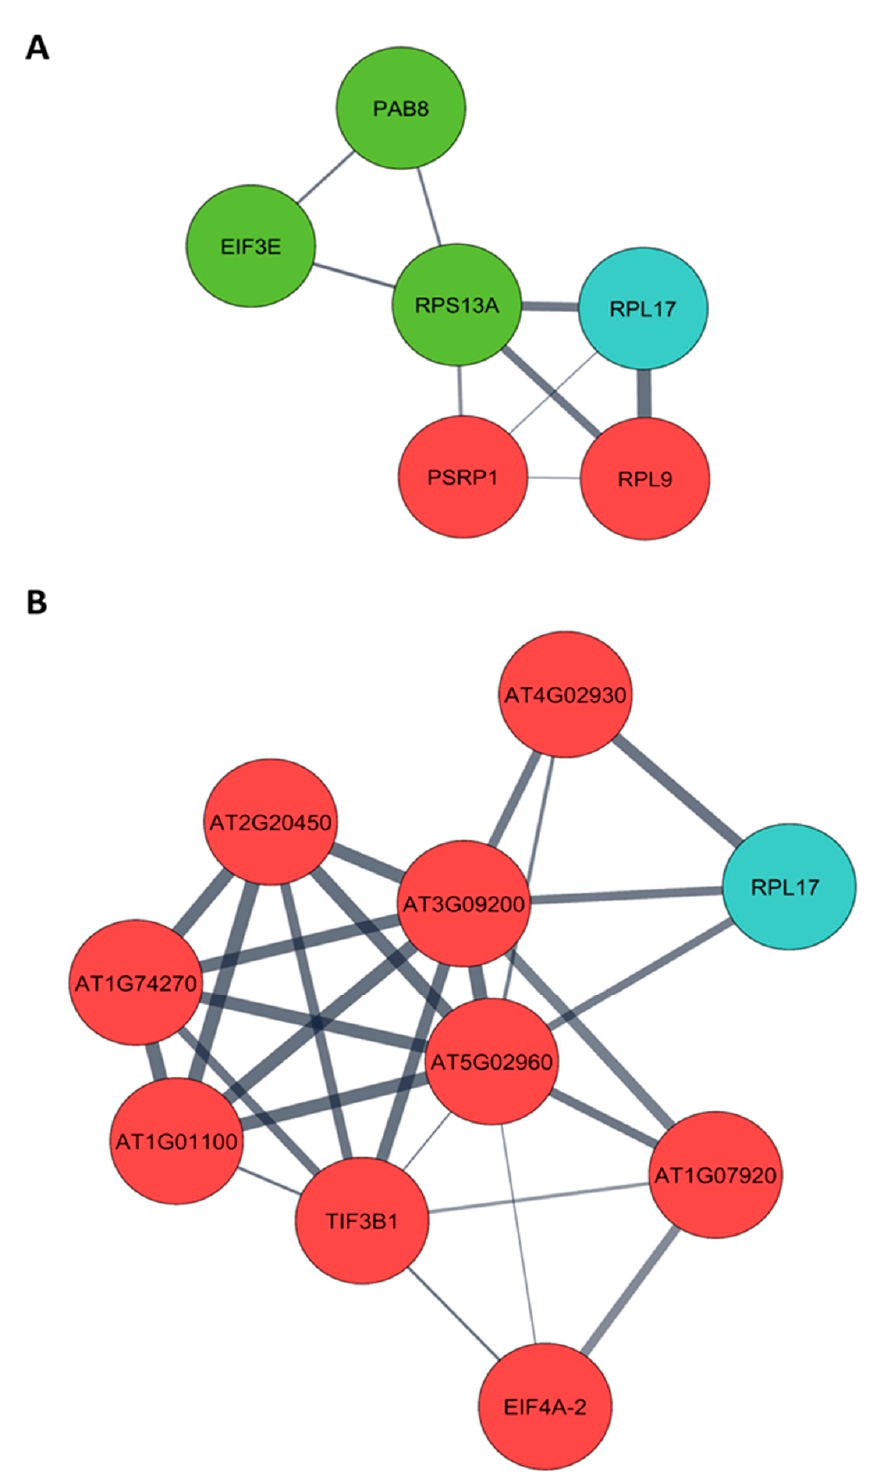
Figure 3. Protein–protein interaction network (PPI) of Carica papaya differentially expressed proteins during PMeV complex infection and PMeV CP2 and CP4-interacting proteins. PPI network of PMeV complex-infected C. papaya at ( A ) pre-flowering stage (4 months post-germination) and ( B ) post- flowering stage (7 months post-germination). The PPI network was filtered to show proteins involved in translation (see Figure S6 for a complete network). Red nodes are up-regulated proteins; green nodes are down-regulated proteins; blue nodes are PMeV CP2 and CP4-interacting